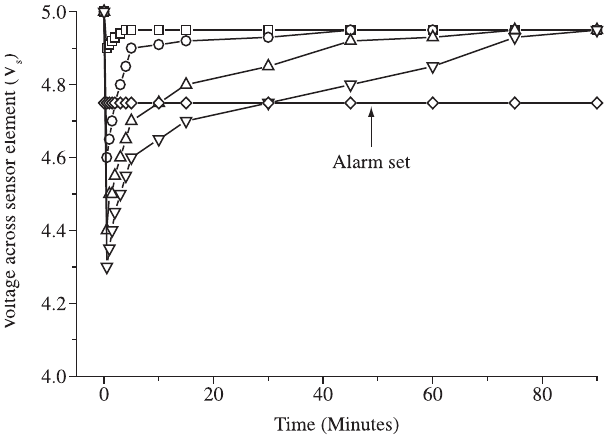
Figure 4. Attainment of operating temperature (250 °C) in two different sensor assemblies: (  ) 1 mm I. D. 5 mm tube, nichrome heating coil, (  ) 3.3 mm I. D. 15 mm length tube, kanthal heating coil.